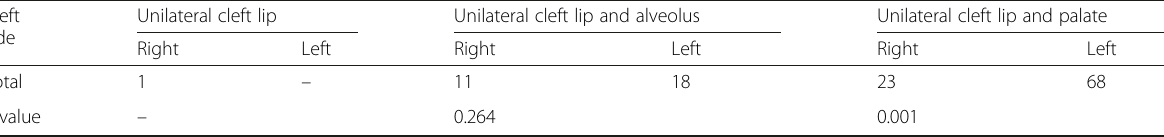
Table 4 Distribution of samples according to cleft side